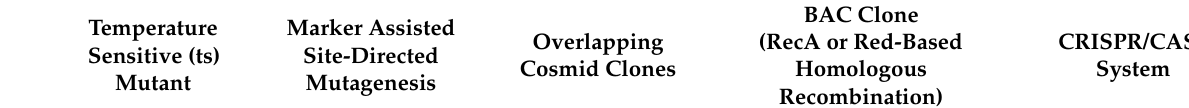
Table 1. Pros and cons of herpesvirus genome manipulation methods.